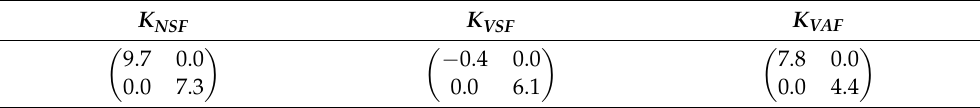
Table 6. Hydraulic conductivity tensors computed on the networks displayed in Figure